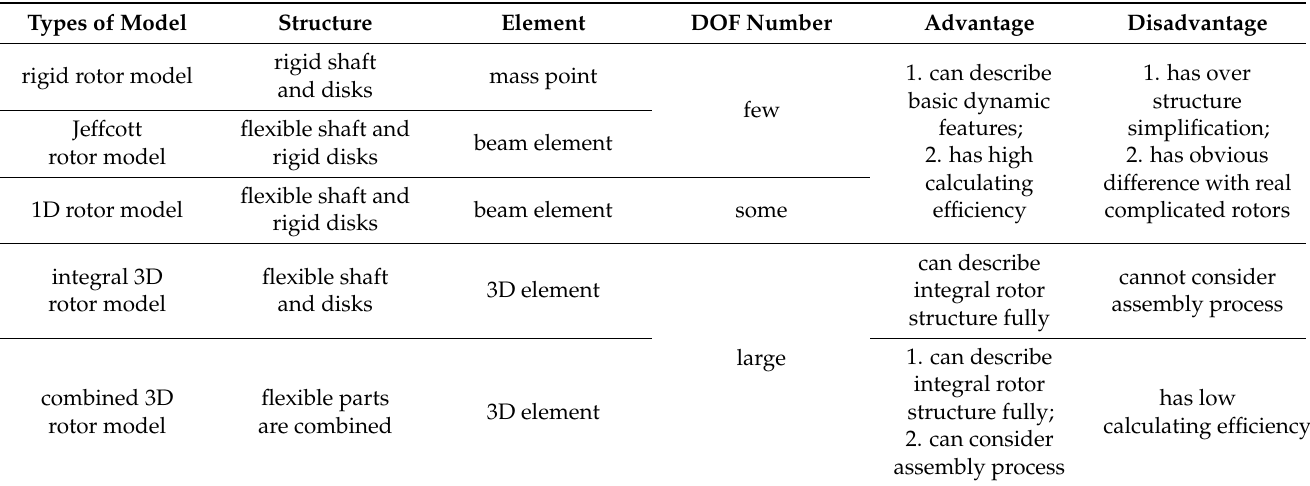
Table 3. The comparison between different rotor